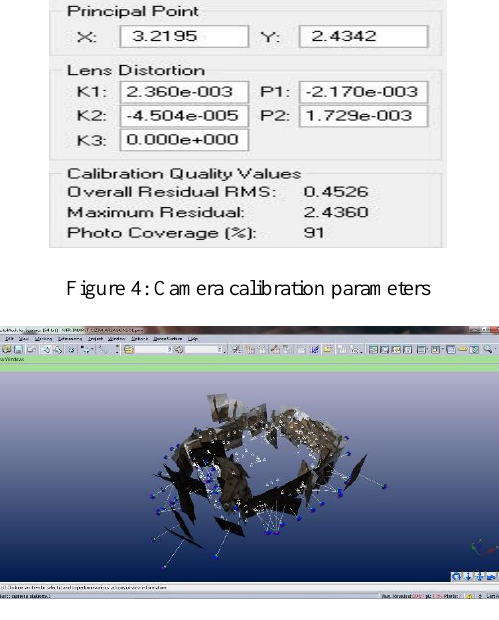
Figure 5. Camera points and control points for Mosque